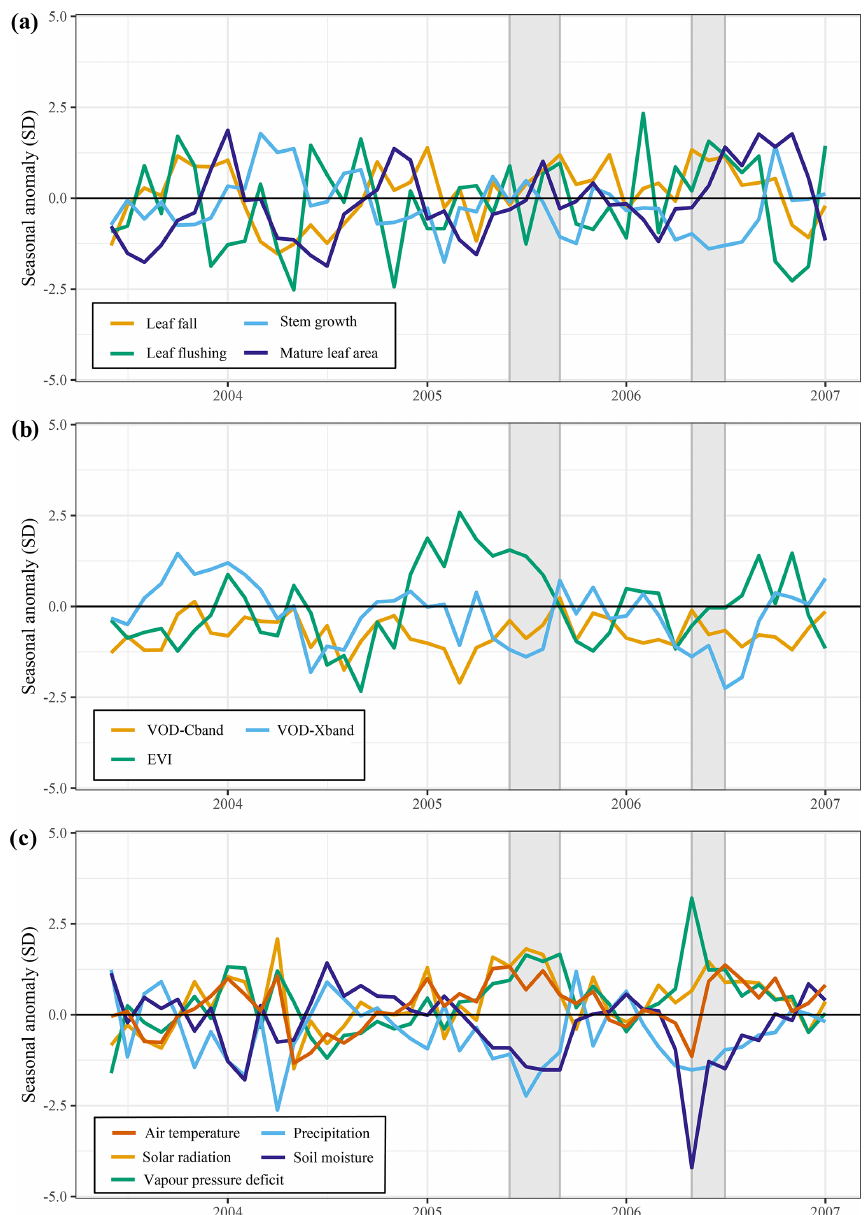
Figure 8. Responses of above-ground growth and remotely sensed vegetation properties to the 2005 drought (June–September 2005) and key climatic variables. All graphs show the trend in the standardized seasonal anomaly, the deviation from the monthly mean divided by the standard deviation of that month. Leaf fall and stem growth (a) are derived from the two separate XGBoost models providing monthly values from January 1982 until September 2019. Mature leaf area (a) is the sum of flushed leaves from 2 to 5 months in the